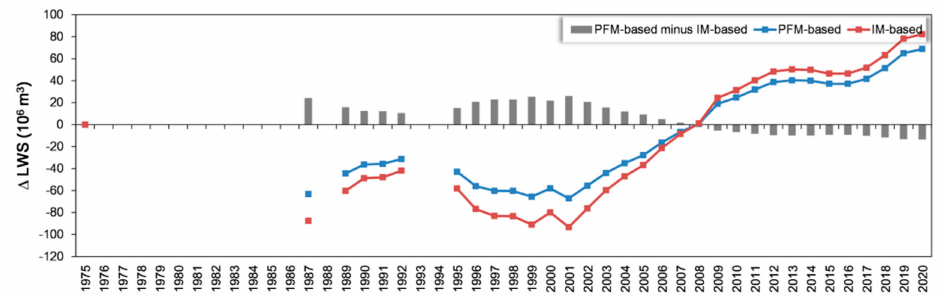
Figure 14. Annual variations in water storage of the lake estimated by the two models. This difference may be explained by the fact that the two models are based on